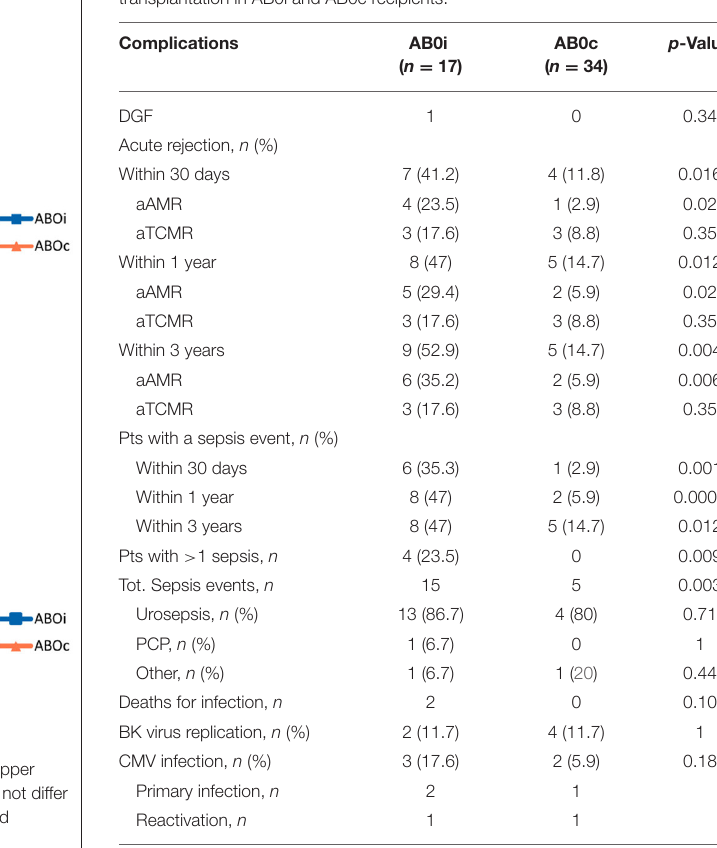
TABLE 2 | Complications registered within 1 month, 1 year and 3 years after transplantation in AB0i and AB0c